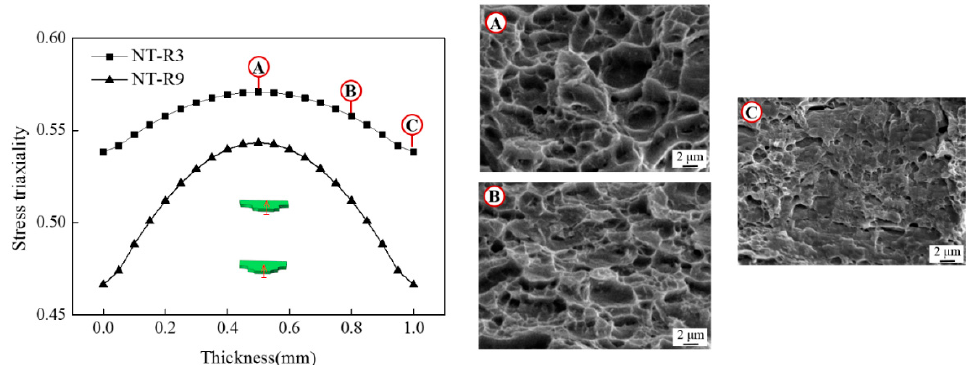
Figure 12. Stress triaxiality along thickness direction of notched specimens.